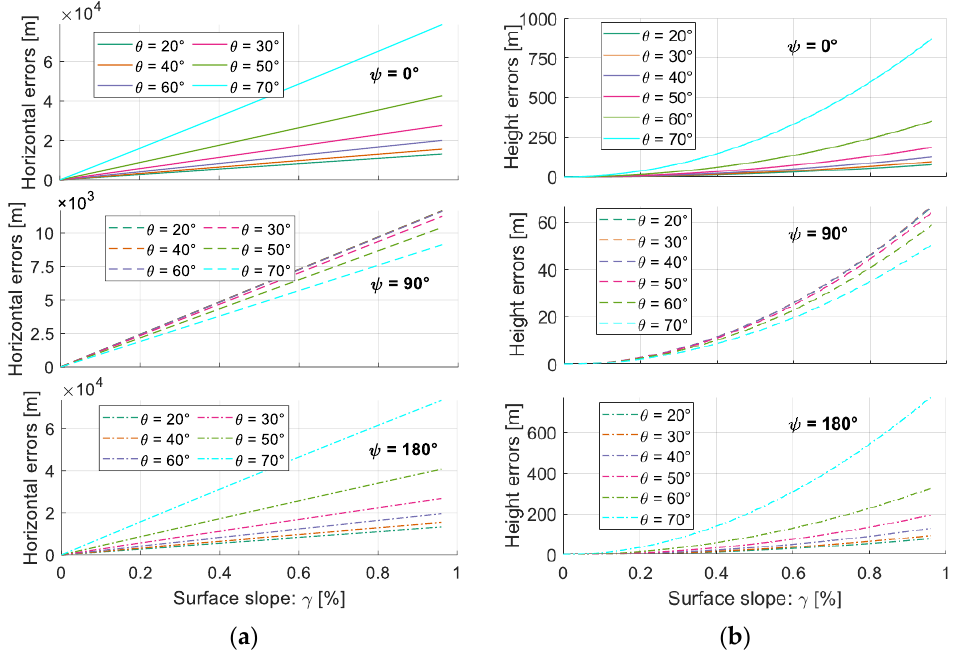
Figure 5. The errors of specular points correspond to different surface slopes and aspects. Horizontal shifts ( a ) and height shifts ( b ) of specular points versus the surface slopes in three slope aspect situations corresponding to the same path range of reflected signal from the ellipsoidal surface.